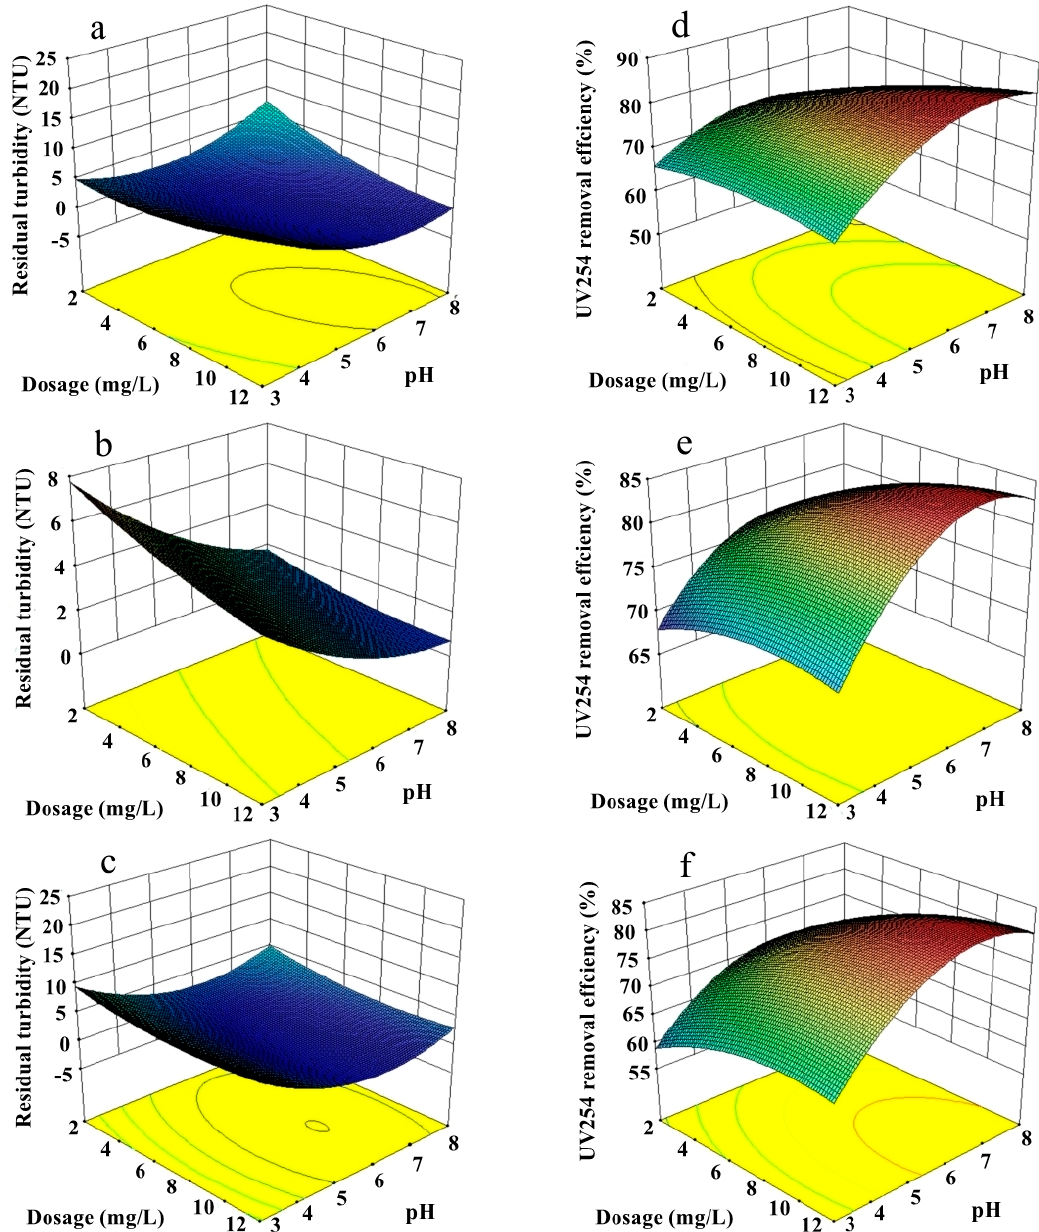
Figure 2. Effect of different factors on residual turbidity: ( a ) Al/Si; ( b ) La/Si; ( c ) basicity and UV 254 removal; ( d ) Al/Si; ( e ) La/Si; ( f ) basicity.